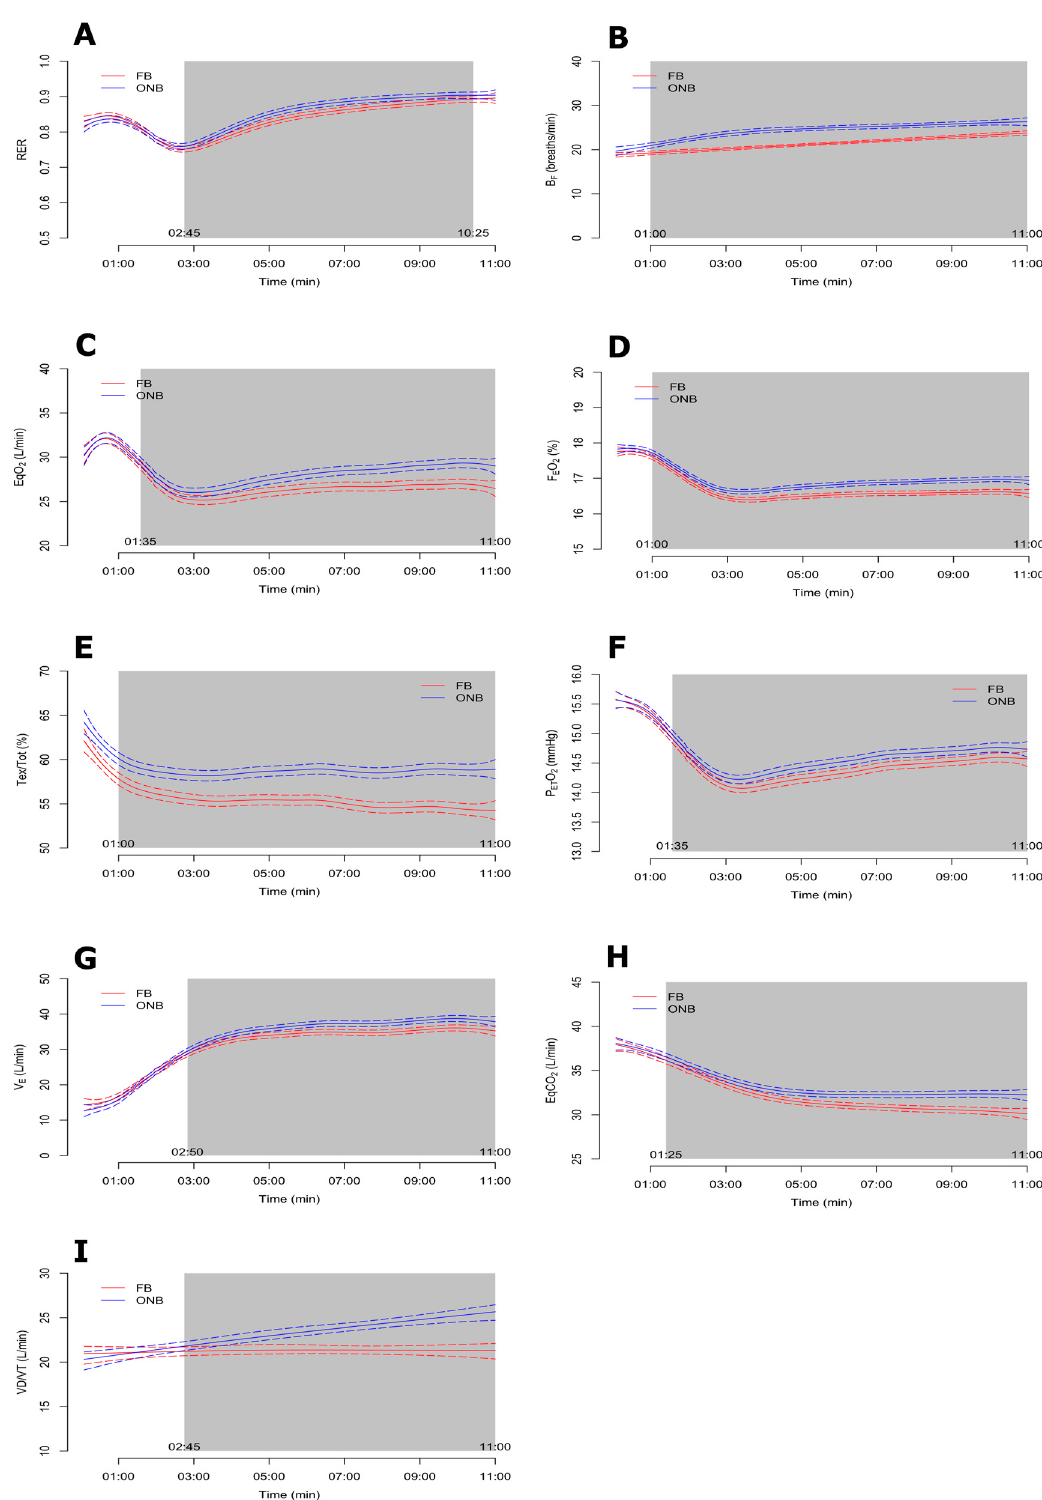
Figure 3. Bayesian functional ANOVA plots for ONB > FB group variables: respiratory quotient (RER) ( A ), breathing frequency (B F ) ( B ), ventilatory equivalent ratio for carbon dioxide (EqCO 2 ) ( C ), fraction of expired oxygen (FEO 2 ) ( D ), expiratory time fraction (Tex/Tot), ( E ), end-tidal partial pressure of oxygen (PETO 2 ) ( F ), minute ventilation (V E ) ( G ), ventilatory equivalent ratio for carbon dioxide (EqCO 2 ) ( H ) and dead space/tidal volume ratio (VD/VT) ( I).